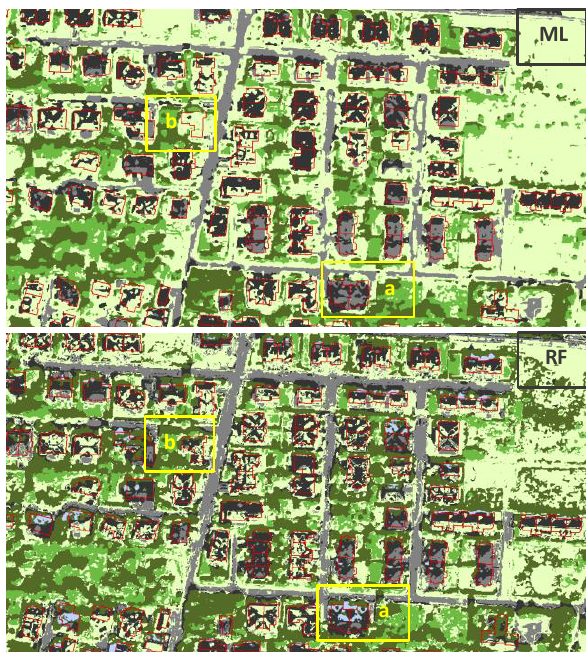
Figure 10. Buildings obtained from ML (up) and RF (down) classification.